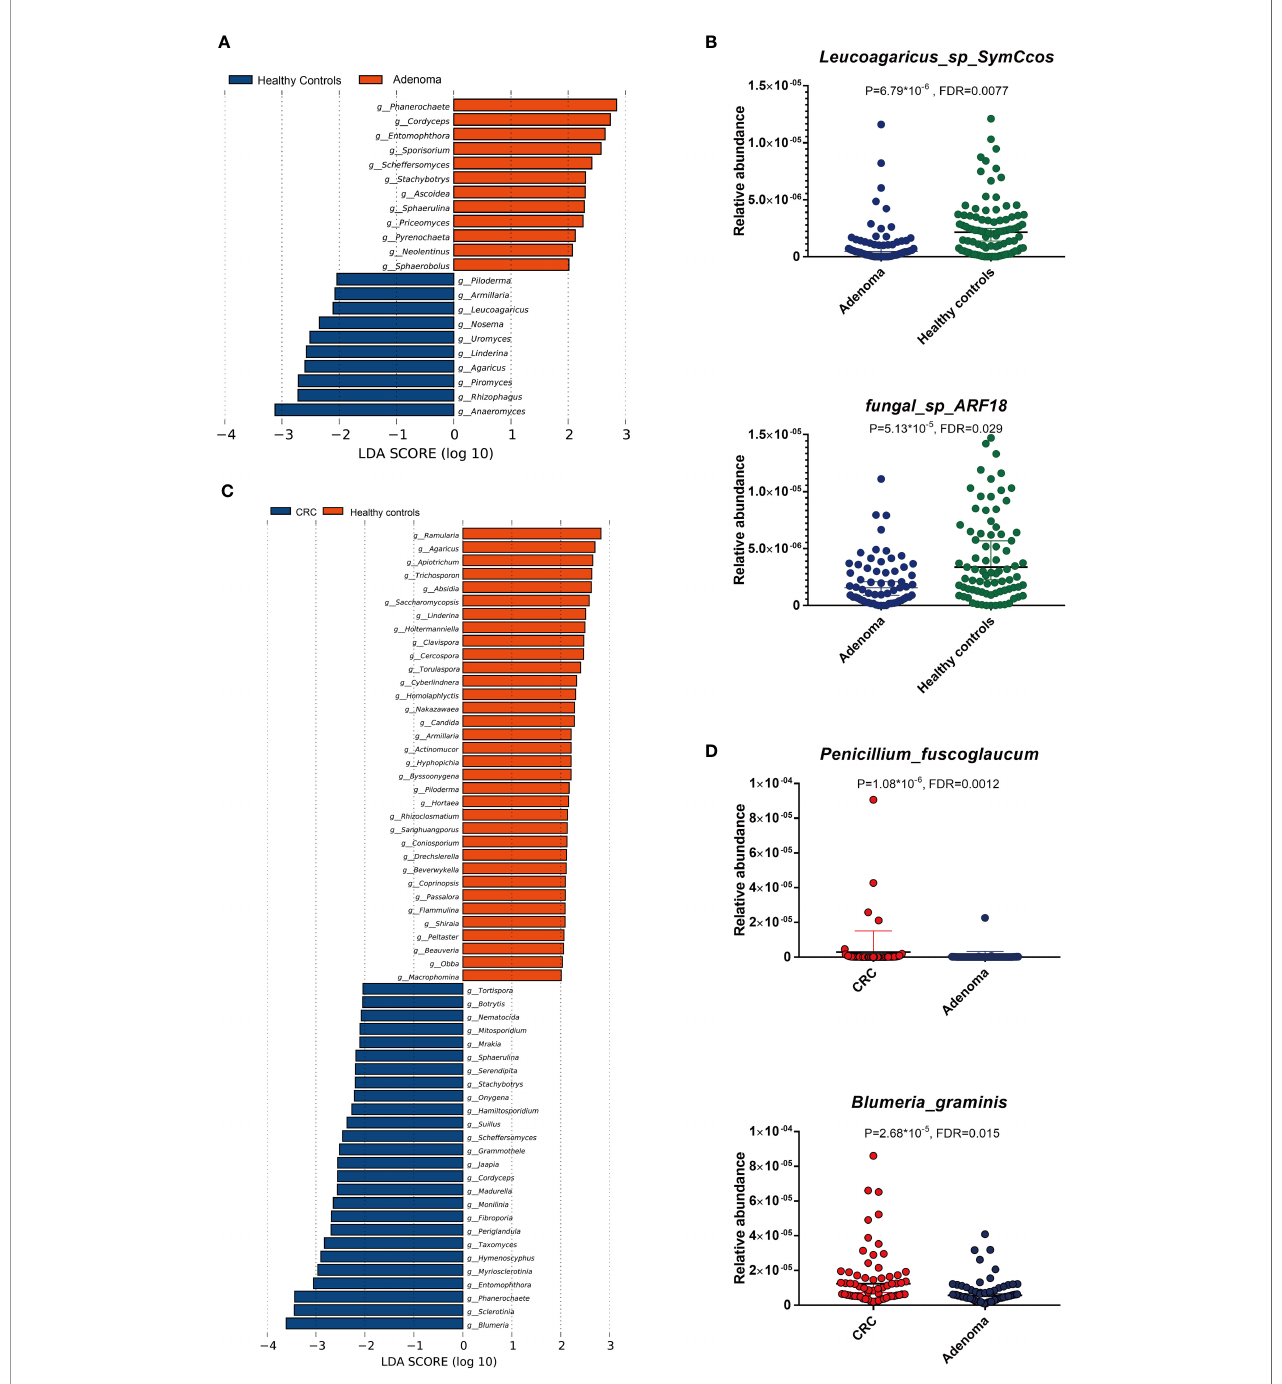
FIGURE 3 | The linear discriminant analysis effect size (LEfSe) analysis revealed dominant gut mycobiota in adenoma and healthy controls (A) . The signi fi cant alterations of two mycobiota between adenoma and healthy controls by Wilcoxon rank-sum test (B) . The enriched gut mycobiota in colorectal cancer and healthy controls based on LEfSe analysis (C) . The signi fi cantly changed gut mycobiota between colorectal cancer and adenoma by Wilcoxon rank-sum test (D) . FDR, false discovery rate.